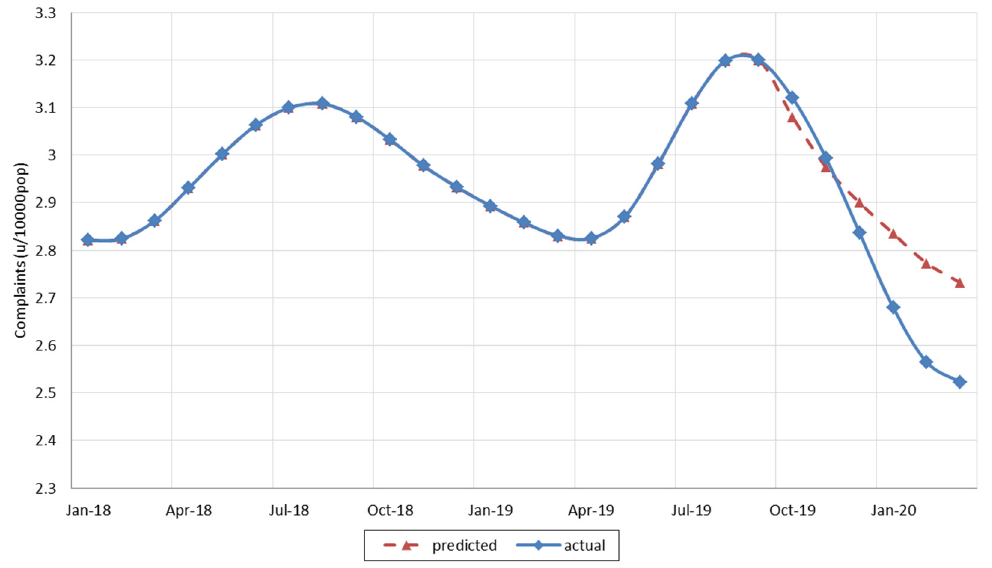
Figure 4. Prediction for the months October 2019 to March 2020 and real data comparison. Feature selection: MOES-RF. Forecasting technique: RF. Table 5. RMSE to 6-step GBV complaints forecasting in Spain.